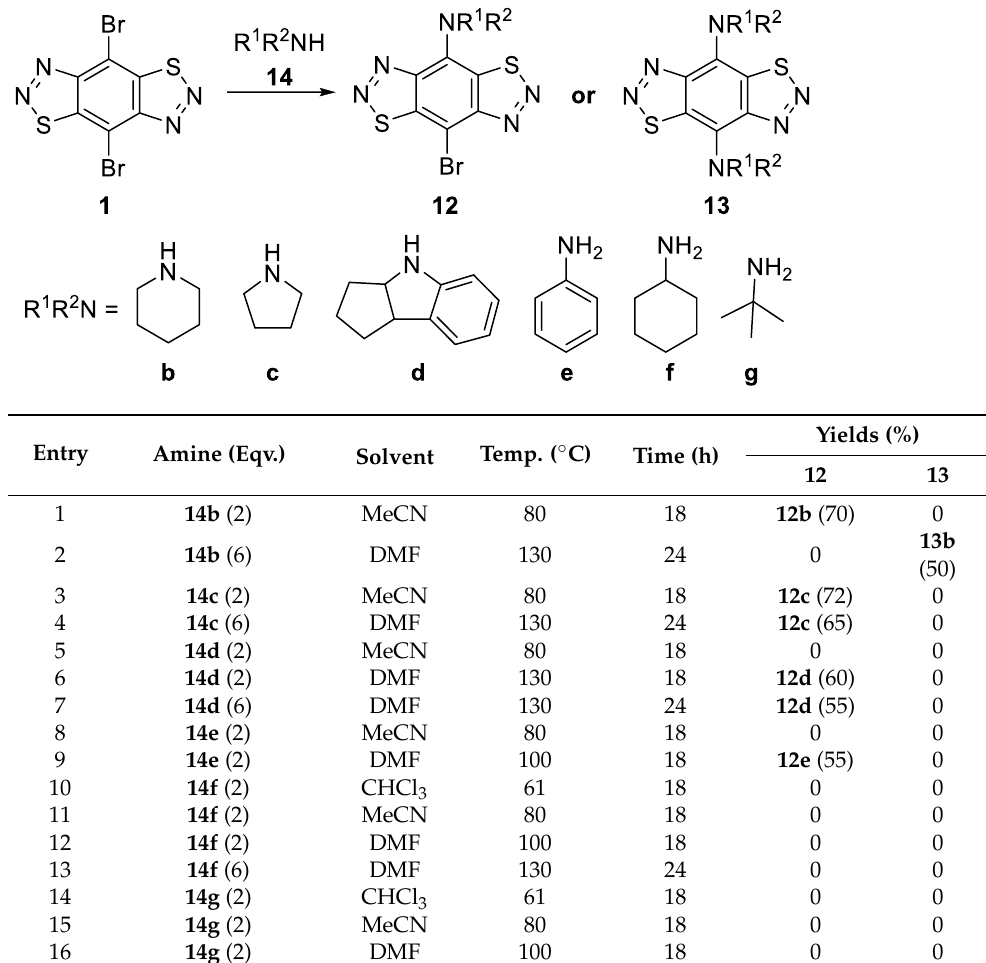
Table 3. The nucleophilic substitution of 4,8-dibromobenzo[1,2- d :4,5- d ’ ]bis([1,2,3]thiadiazole) 1 with aromatic and aliphatic amines.